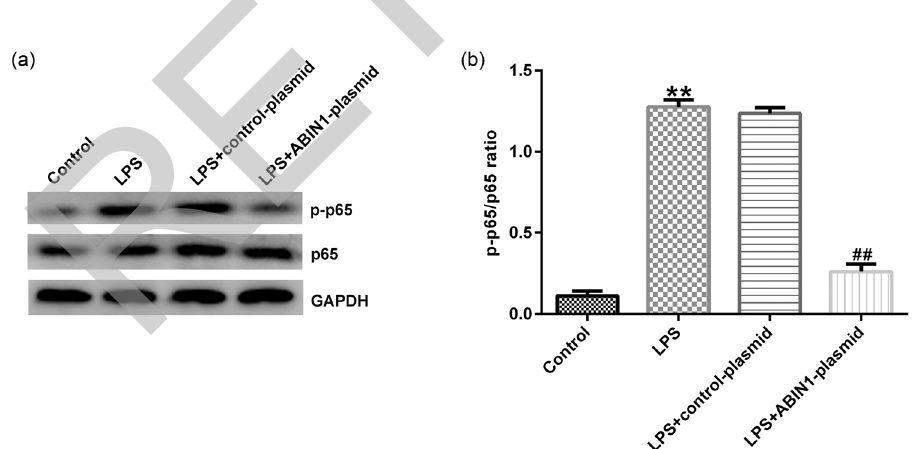
Figure 3: ABIN1 - plasmid suppressed LPS - stimulated NF - κ B activation in macrophages. Control - plasmid or ABIN1 - plasmid was transfected into macrophages for 48 h, followed by LPS treatment. ( a ) Western blot analysis was adopted to evaluate p - p65 and p65 expression in four groups ( control, LPS, LPS + control - plasmid, and LPS + ABIN1 - plasmid ) . ( b ) Ratio of p - p65/p65. ** p < 0.01 vs control, and ## p < 0.01 vs LPS + control -